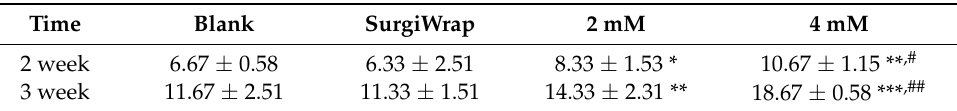
Table 3. Average scores obtained from hematoxylin and eosin staining and picrosirius red staining (modified from Table